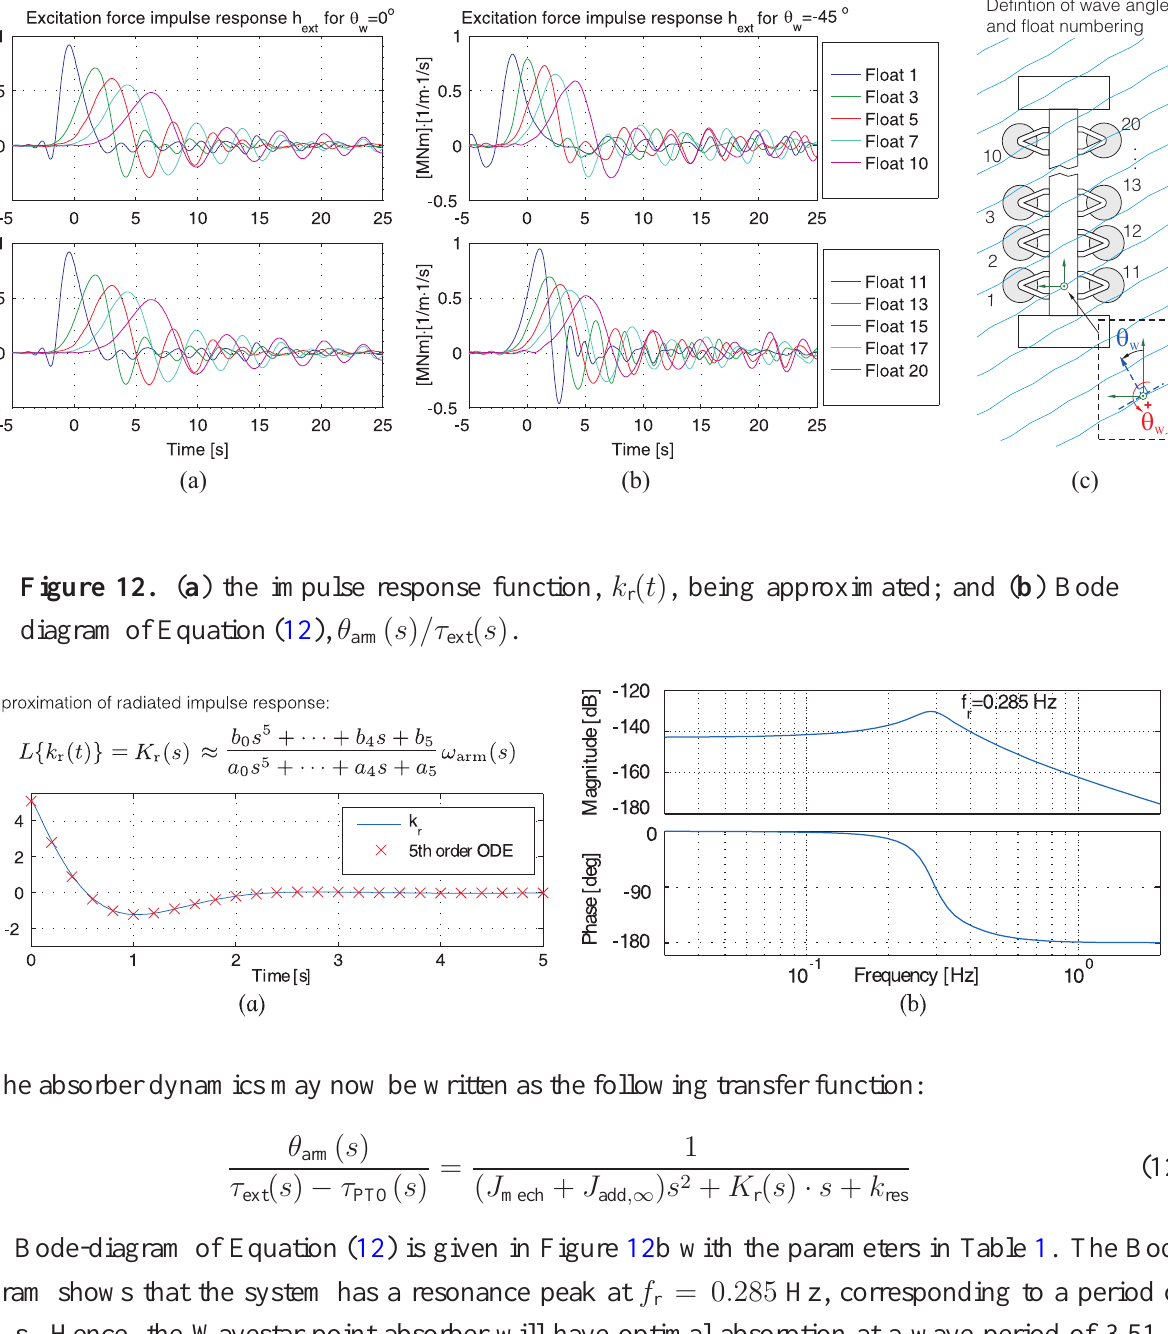
Figure 11. The wave excitation force filter impulse responses, h for wave direction, η “measurement” point, float numbering and wave angle, θ